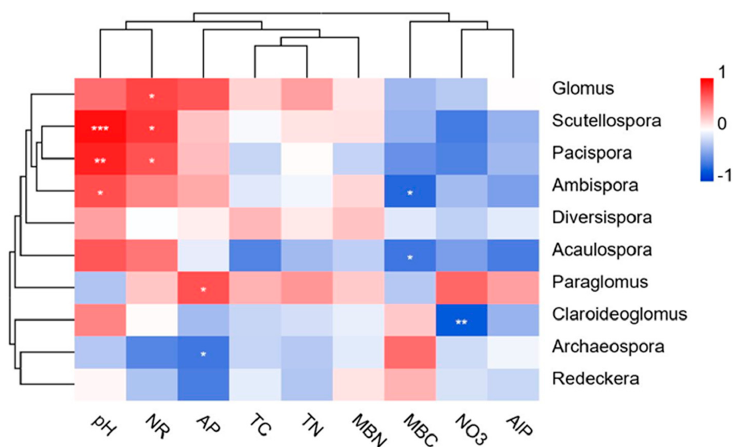
Figure 6. Heatmap analysis of the relationships between the AMF genera and environmental factors. Significant correlations are shown by * p < 0.05, ** p < 0.01, and *** p <